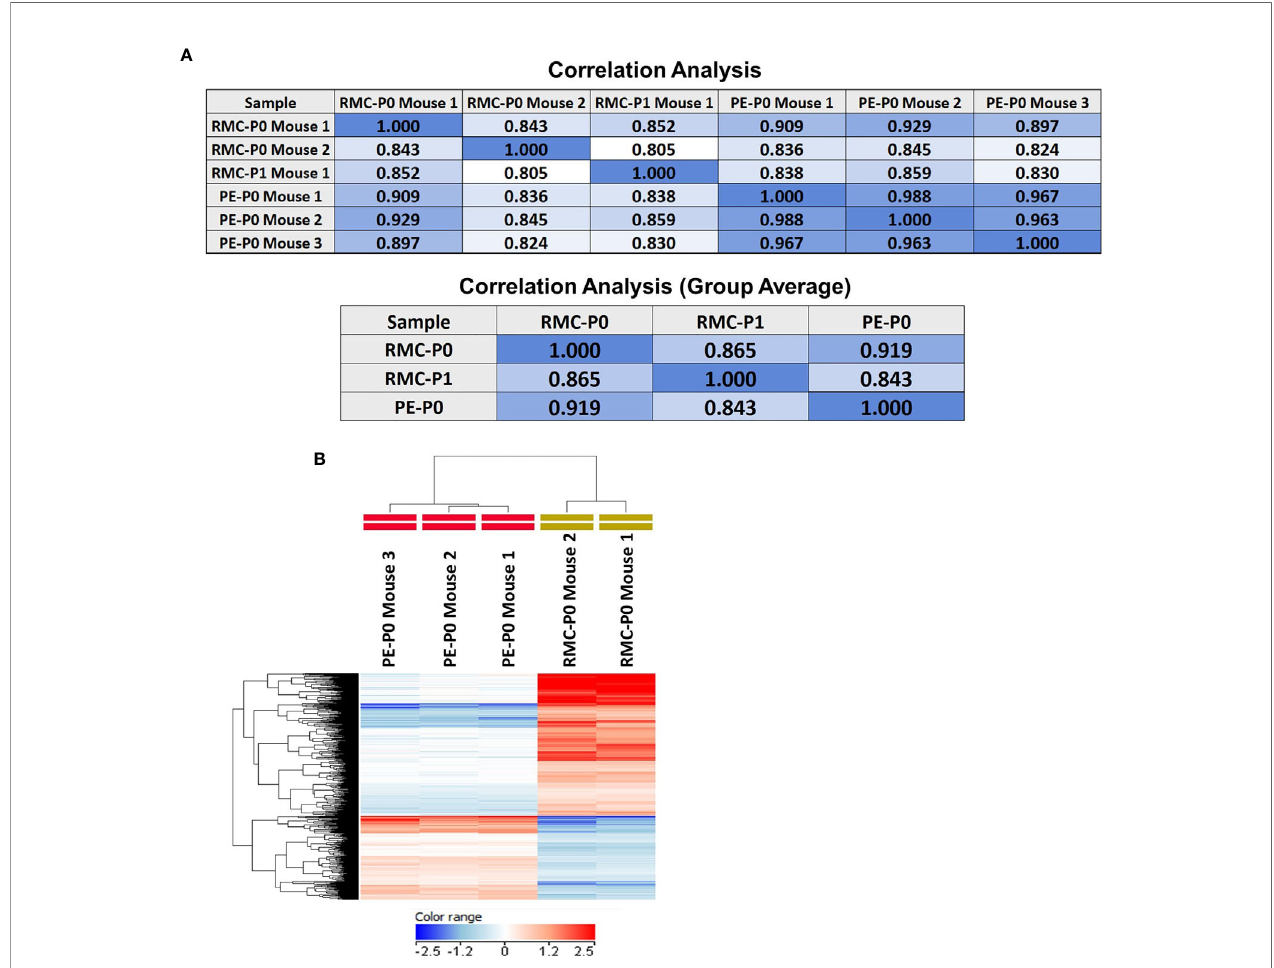
FIGURE 3 | Gene expression pro fi ling demonstrates that the PE model faithfully recapitulates the molecular features of the renal tumor PDX. Microarray gene expression pro fi ling of the P0 and P1 renal tumor PDX and the PE PDX tumors was performed as described in Methods . (A) Pearson correlation analysis performed on the fi ltered expression data demonstrated high concordance between the PE PDX and each of the renal tumor PDXs, as well as between both generations of renal tumor PDX. There was also very high concordance between individual PE PDX samples. Coef fi cients are presented in correlation matrices. (B) Differential expression analysis was performed by group-wise comparison of PE-P0 vs RMC-P0 PDX data (moderated T-test, FDR-corrected p<0.05) followed by hierarchical clustering of the DEGs. The results were visualized with a heat map and demonstrate that the RMC-P0 and PE-P0 samples cluster as two distinct branches of the dendrogram based on clustering of their gene expression patterns depicted by relatively higher (red) or lower (blue) expression across the individual samples and tumor